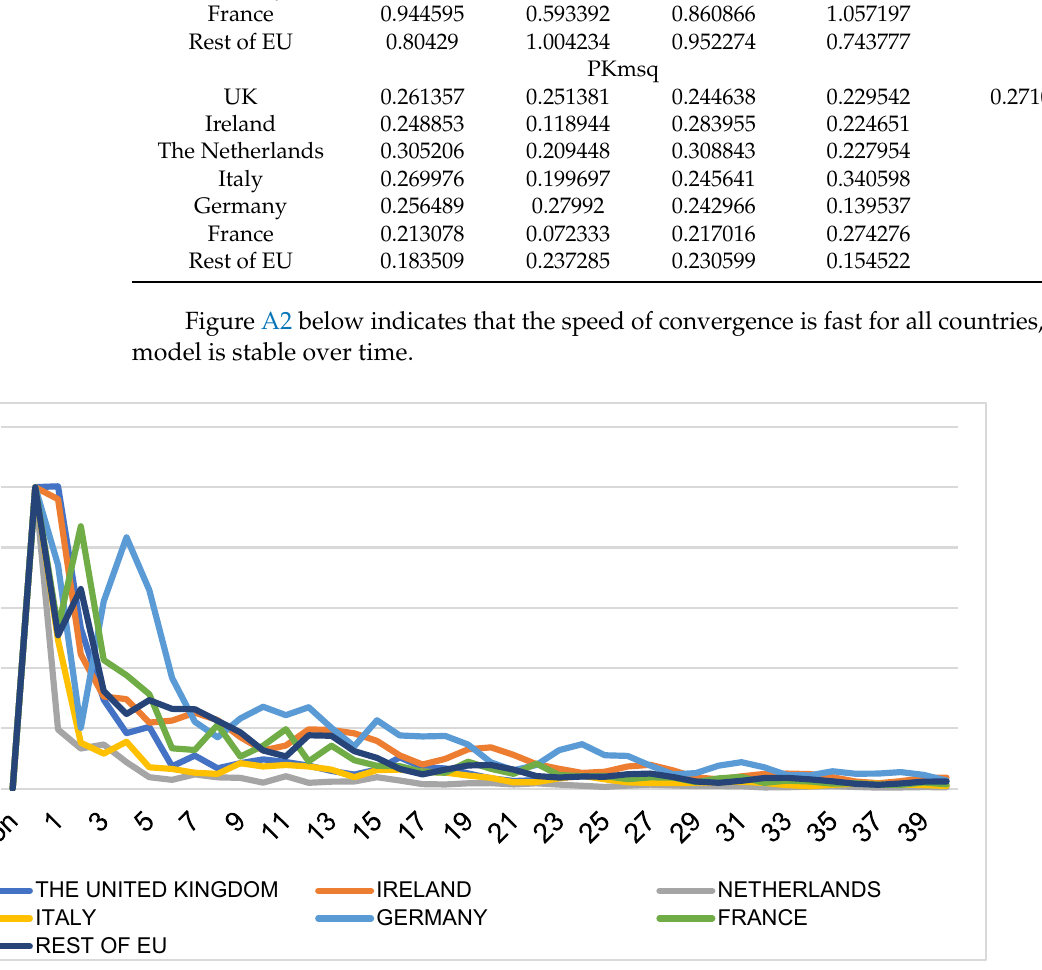
Figure A2. Persistence profile of the effect of system-wide shocks to the cointegrating relations of the intra-EU GVAR model.